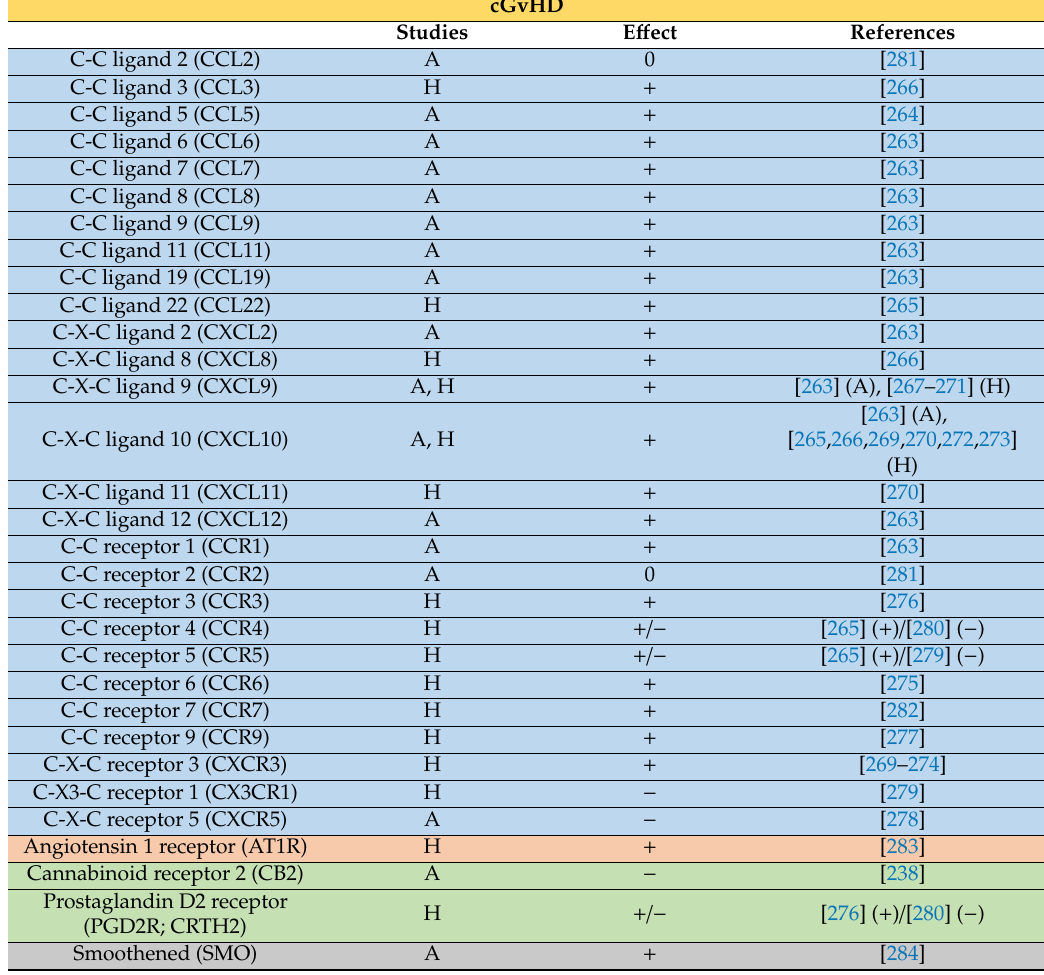
Table 4. Chronic GvHD occurrence / severity in animal (A) or human (H)studies. See the Methods section regarding the reporting of results (Section